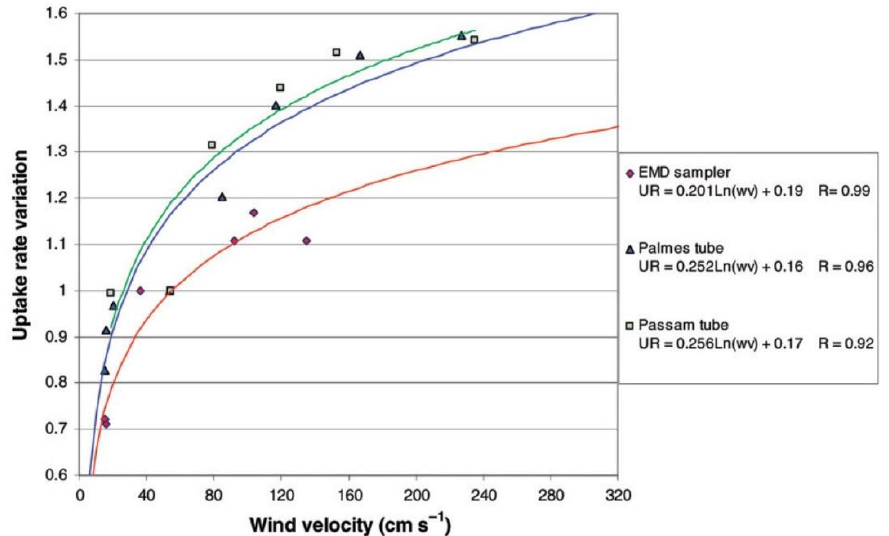
Figure A1. Uptake rates as a function of wind velocity for three types of NO 2 passive samplers in a controlled chamber at 20 ◦ C, 40–50% relative humidity (RH) and 200 µ g m − 3 NO 2 concentration. The uptake rates are expressed relative to that measured for a wind speed of 0.50 m s − 1 . Figure reproduced from Plaisance [36] with permission of Taylor and Francis. (EMD stands for Ecole des Mines.)